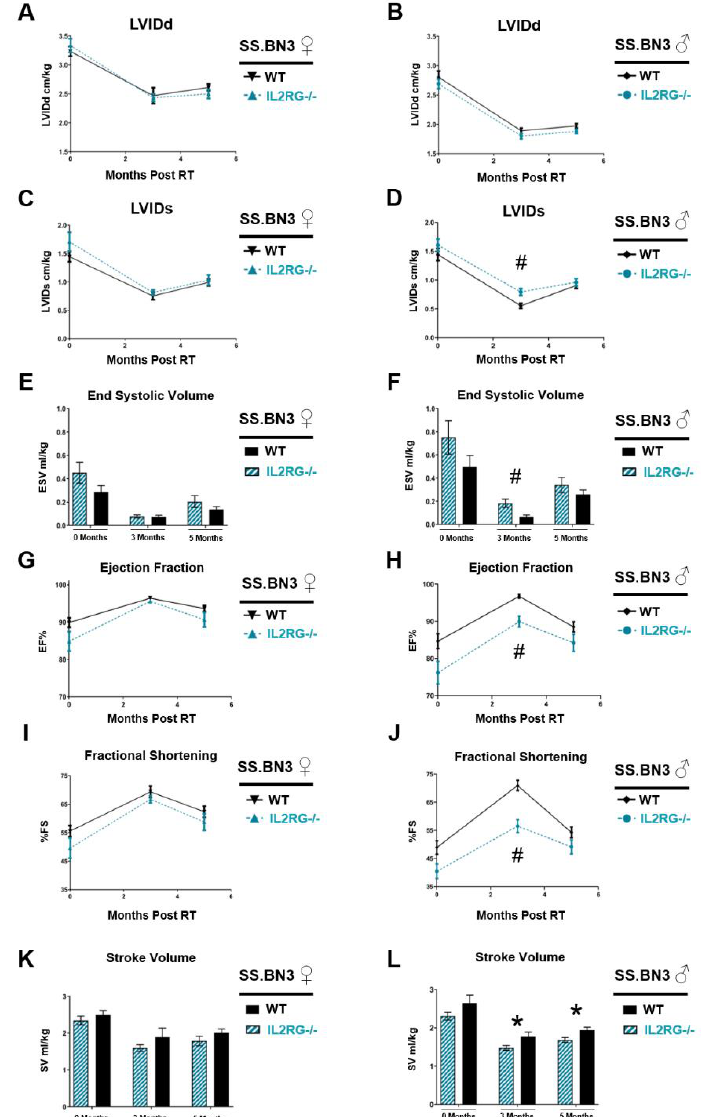
Figure 8. The consomic SS.BN3 rats exhibit some differences in cardiac function from the SS rat strain when comparing immune-compromised (IL2RG −/− ) versus WT rats after single-dose cardiac RT. After receiving 24 Gy of localized cardiac RT, only the male SS.BN3 IL2RG −/− rats had echocardiogram parameters indicating poorer heart function, while both male and female SS IL2RG −/− rats had parameters indicating poorer cardiac function compared to WT SS rats (Figure 5). The left-ventricular internal diameter at end-diastole (LVIDd) ( A : female; B : male) was not significantly different in SS.BN3 IL2RG −/− versus SS.BN3 WT rats, and LVIDs ( C : female; D : male), had significantly decreased values in IL2RG −/− rats only in males at three months post-RT ( D ). End-systolic volume (ESV) was not significantly different in female ( E ) but was increased at three months post-RT in male ( F ) SS.BN3 IL2RG −/− versus SS.BN3 WT rats. In females, ejection fraction (EF) ( G ) and fractional shortening (FS) ( I ) were not significantly different, whereas, in males, EF ( H ) and FS ( J ) were significantly decreased at three months post-RT in the SS.BN3 IL2RG −/− rats, indicating poorer cardiac function. Stroke volume (SV) was not significantly different in ( K ) female but was in ( L ) male rats at three and five months post-RT, with statistical decreases in the SS.BN3 IL2RG −/− versus SS.BN3 WT rats, also suggesting worse cardiac function. Values are means ± SEM; n = 7–13 rats/group, * p < 0.05, # p < 0.01.